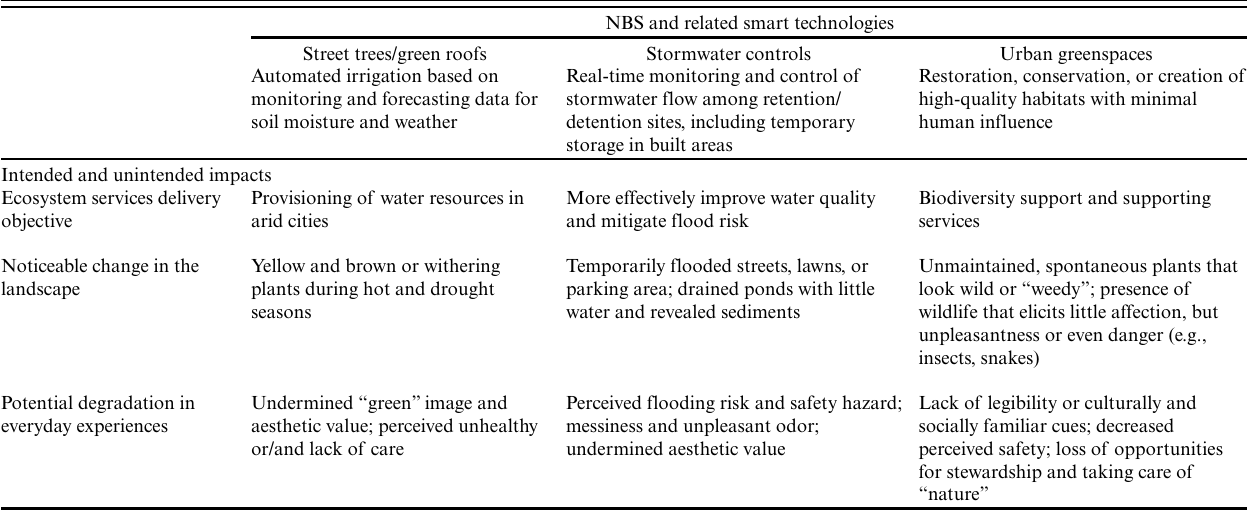
Table 1 . Examples of ways smart technologies might be employed in nature-based solutions (NBS) and their potential effects on everyday experience. Note that these examples are speculative; we do not intend to review existing practices or predict future trends